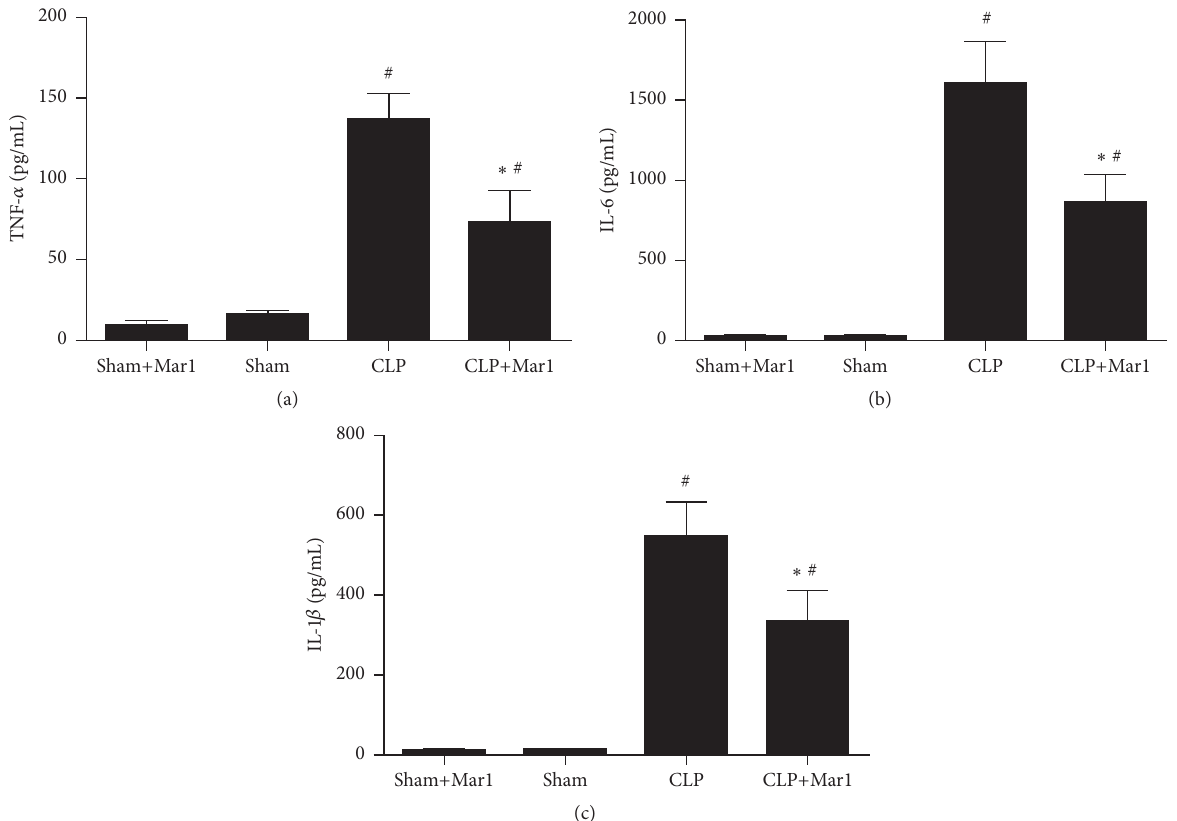
Figure 3: Inhibition of proinflammatory cytokines by Mar1 in CLP animals. Levels of TNF- 𝛼 (a), IL-6 (b), and IL-1 𝛽 (c) in serum were determined by enzyme-linked immunosorbent assay. Data are expressed as means ± SEM. 𝑛 = 6 . # 𝑃 < 0.05 versus the sham group. ∗ 𝑃 < 0.05 versus the CLP